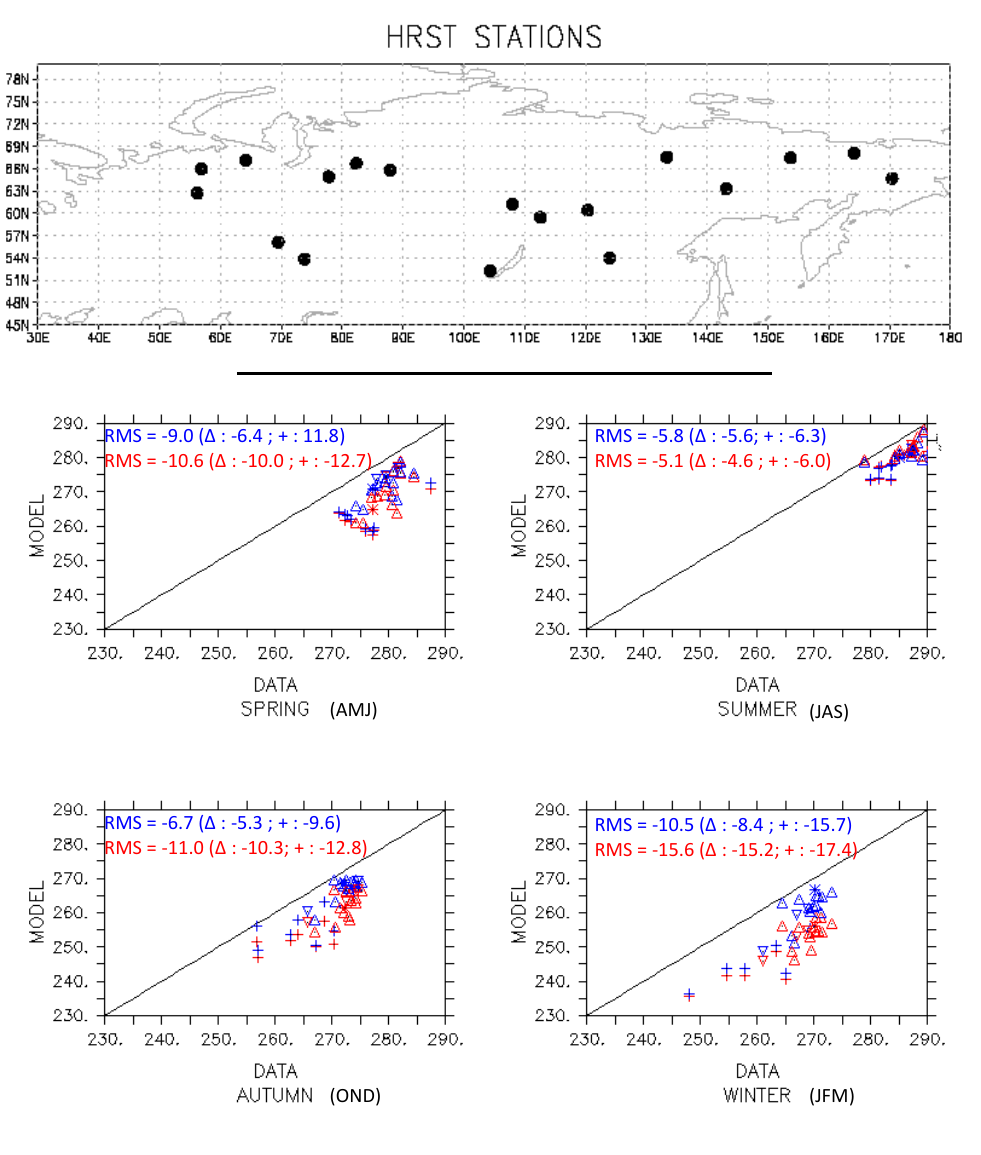
Fig. 8. Top: HRST stations locations. Bottom: comparison between observed (x-axis) and modeled (y-axis) soil temperatures at depths from 0 to 20cm at the HRST stations, averaged over the decade 1984–1994. Colors refer to the model with and without the soil new soil freezing scheme; symbols discriminate between the sites where the snow depth is either properly represented by the model within a ± 20cm range (correct snow), or underestimated by the model (snow underestimation), or overestimated by the model (snow overestimation) when compared to the climatological dataset by Foster and Davy